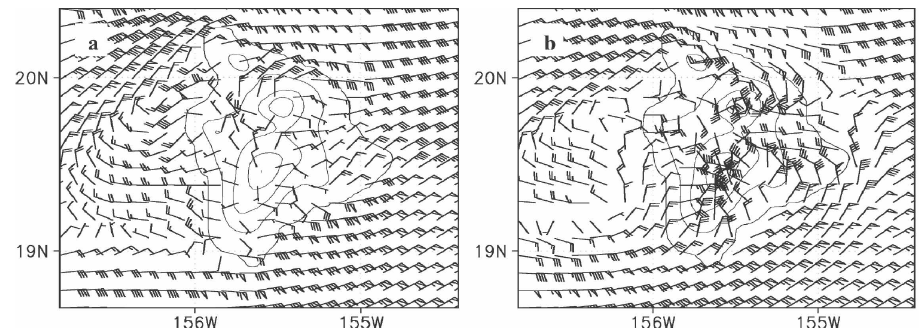
Figure 4. Time-averaged surface winds for a long-term simulation of trade-wind flow over Hawaii at ( a ) 1400 and ( b ) 0200 Hawaiian Solar Time (HST), from Yang and Chen [41]. Pennants, full barbs, and half barbs represent 5, 1, and 0.5 m s − 1 , respectively. c (cid:13) American Meteorological Society. Used with permission.